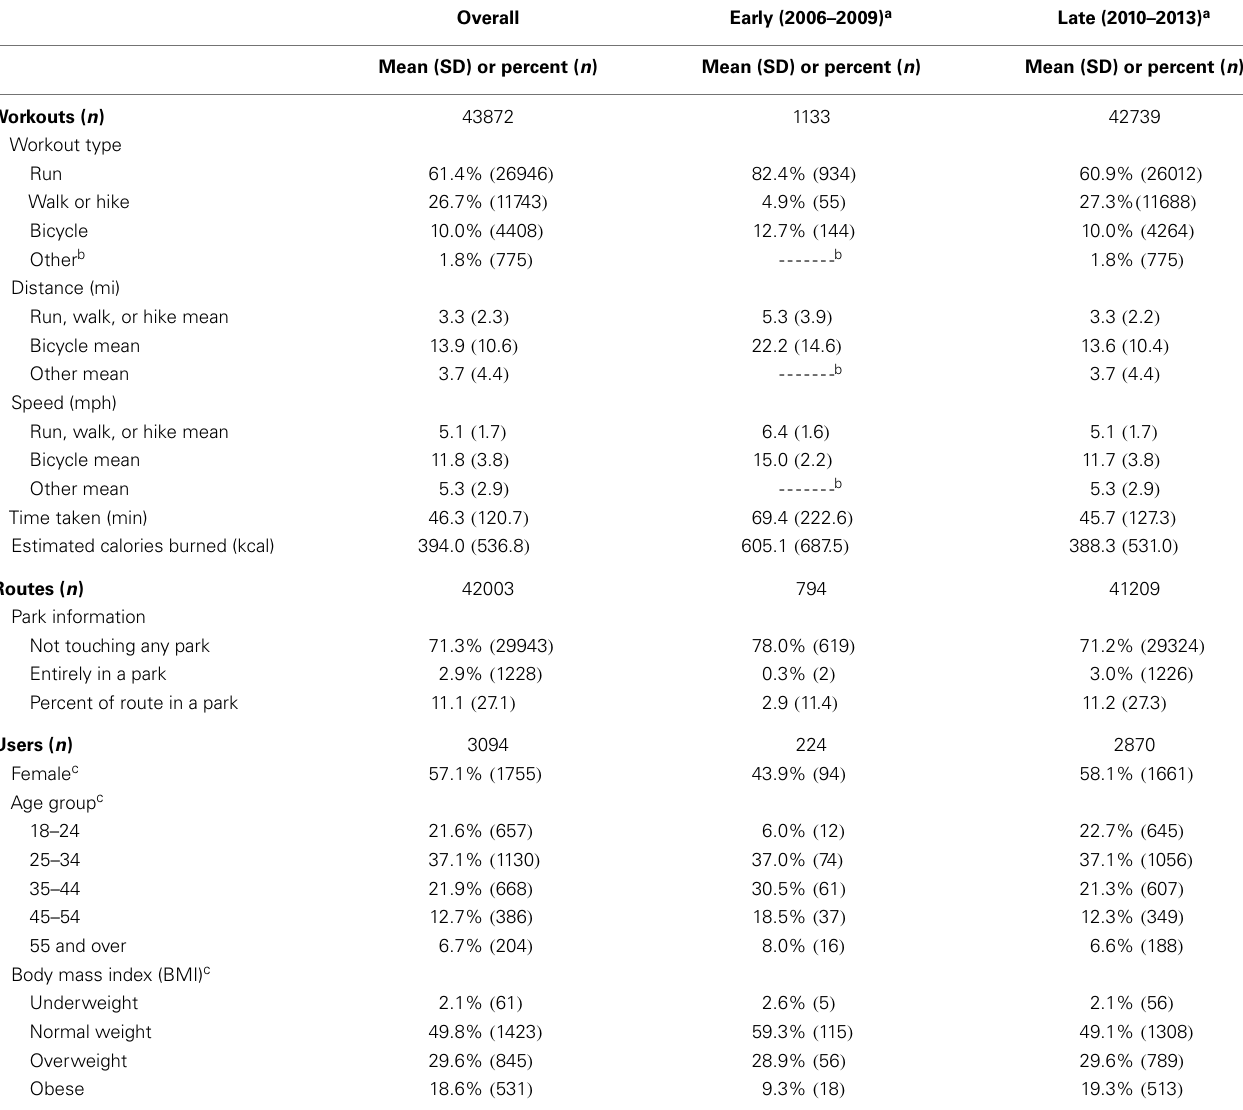
Table 1 | Characteristics of MapMyFitness workouts, routes, and users withinWinston-Salem, NC, USA overall and by time period (June 2006–September 2013)